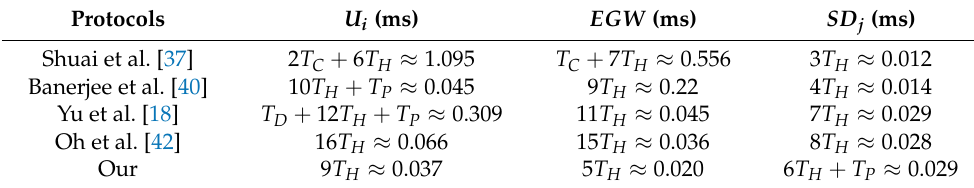
Table 5. Computational cost